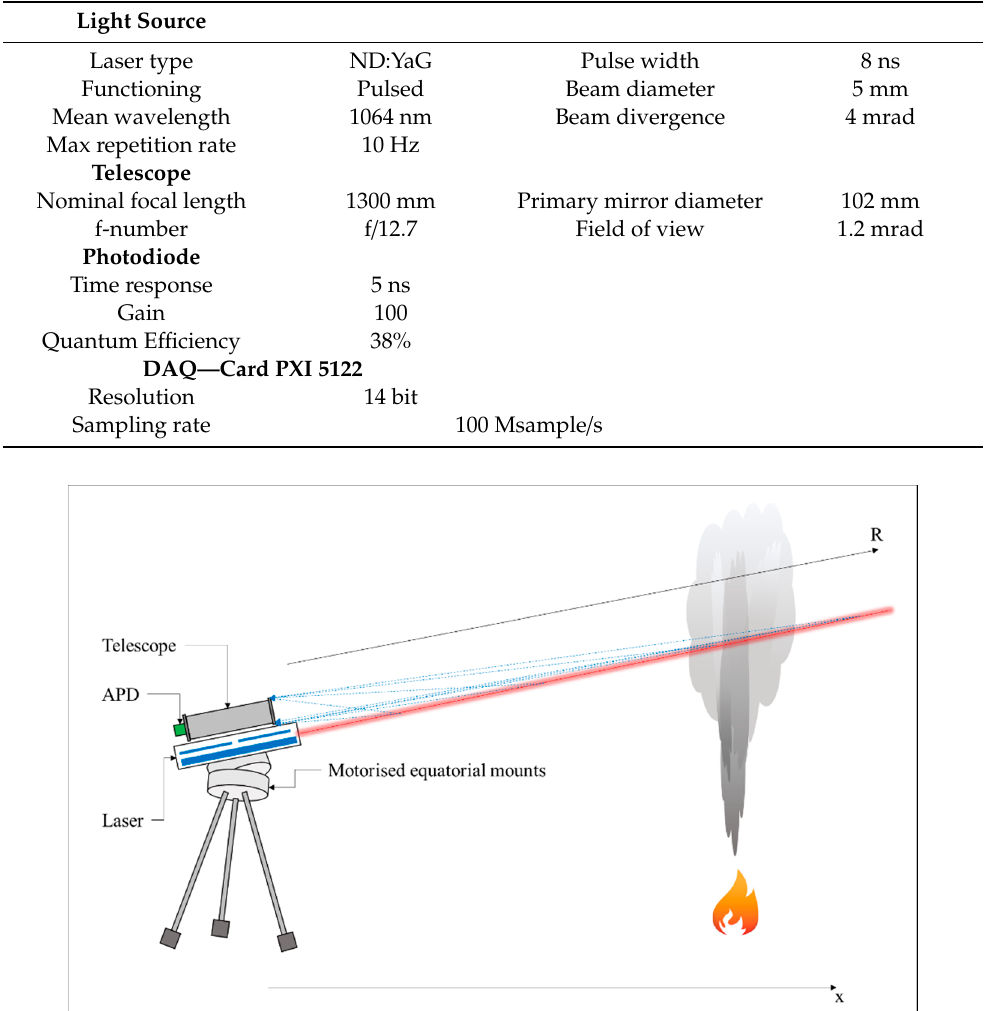
Figure 1. Scheme of the experimental apparatus. Table 1. Characteristics of LiDAR main components.